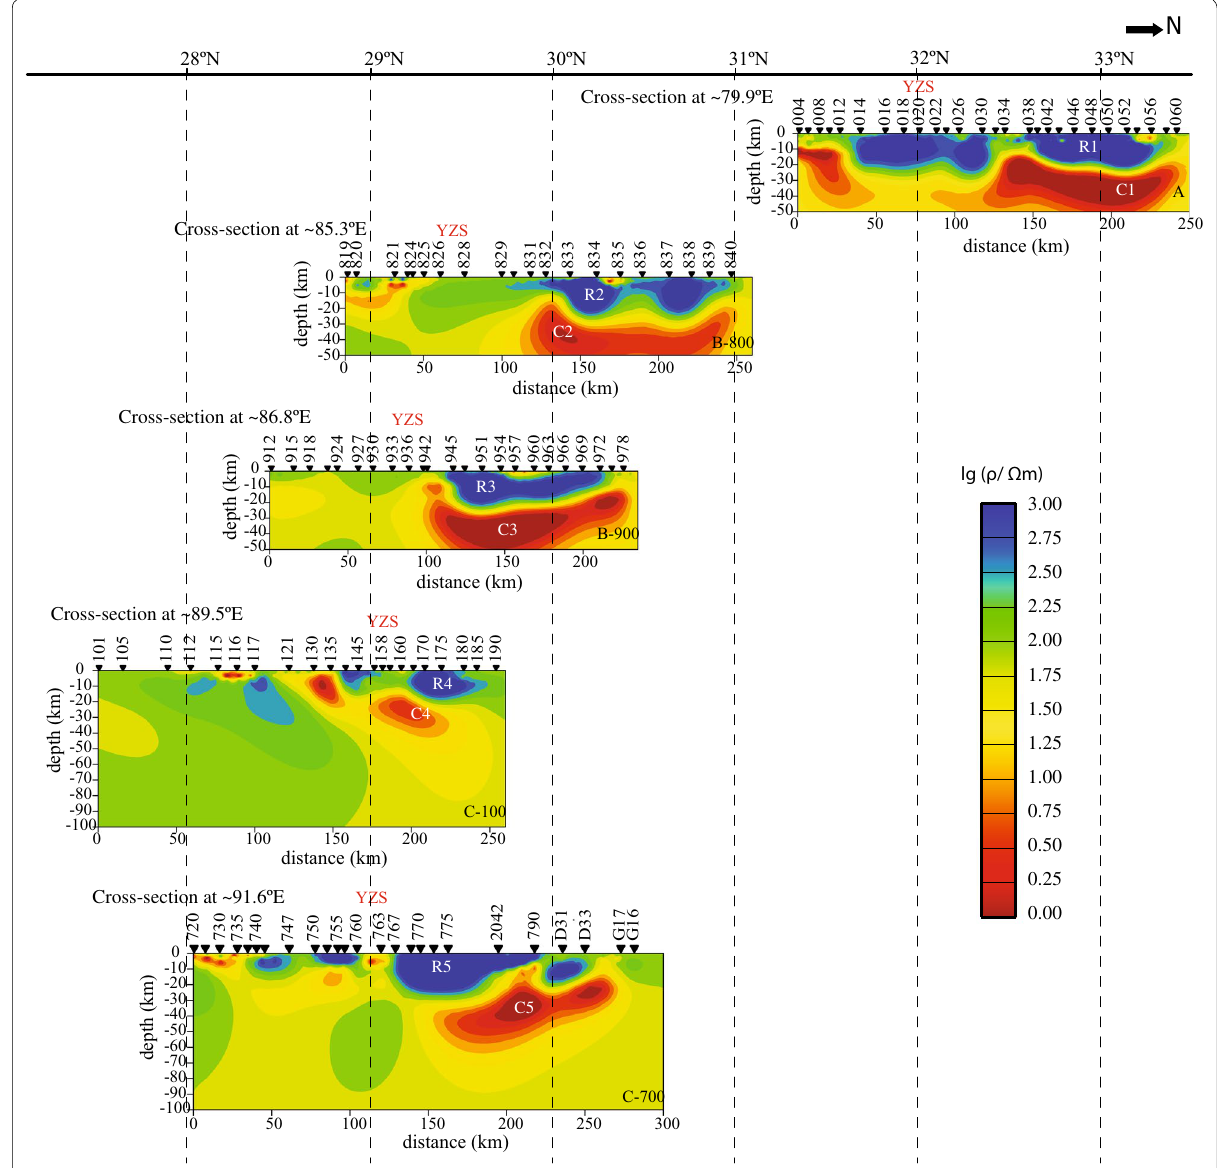
Fig. 9 Resistivity cross-sectional maps along different longitudes in southern Tibet. R1 to R5 are the imaged resistivity bodies, whereas C1 to C5 are the